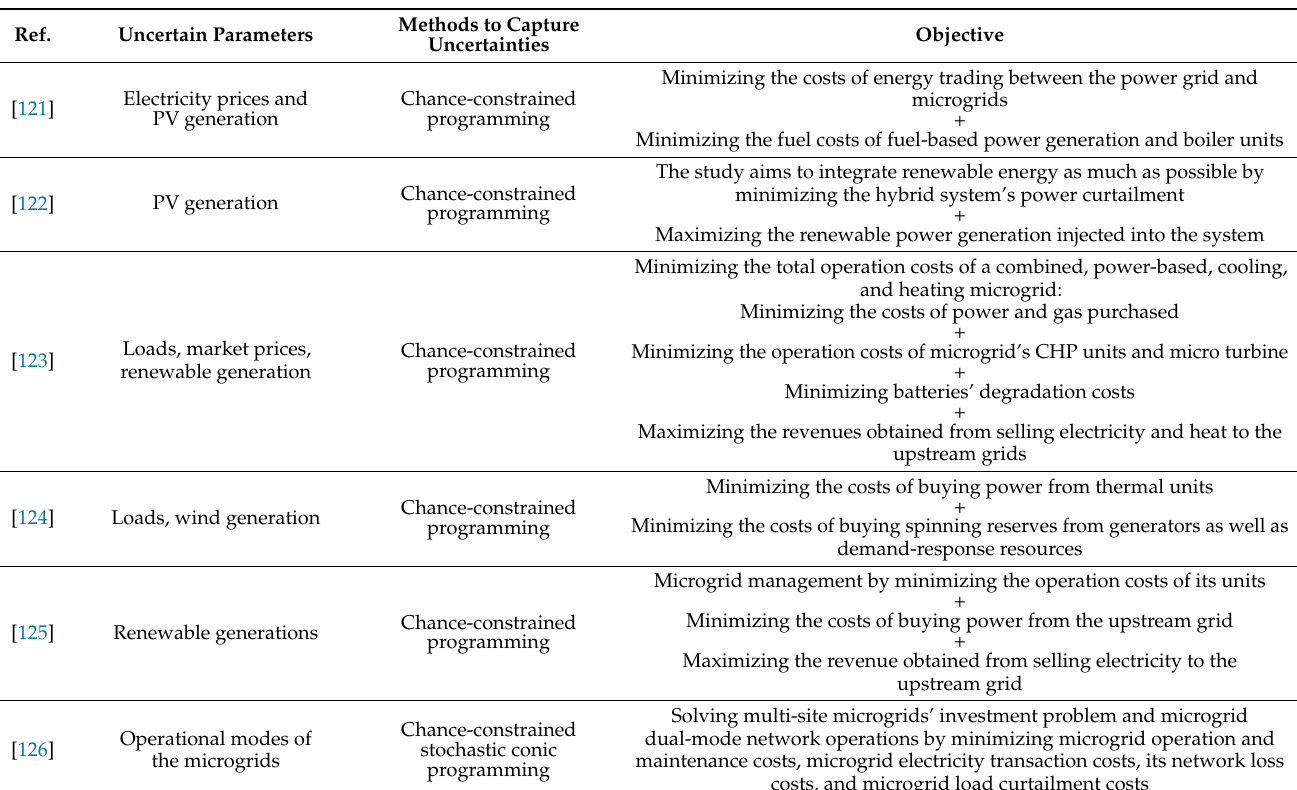
Table 8. An overview of recent papers using chance-constrained programming for decision making in a smart grid